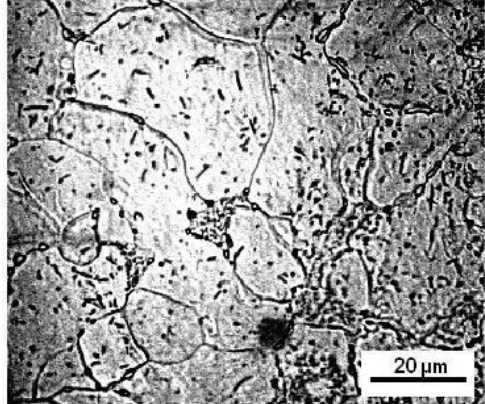
Figure 8: Replica RA10-R1. Assessment of the microstructure [11]: Level B / Level C: Initial spheroidization and carbide precipitation per grain boundary in places with the presence of globular pearlite. 4% nital.